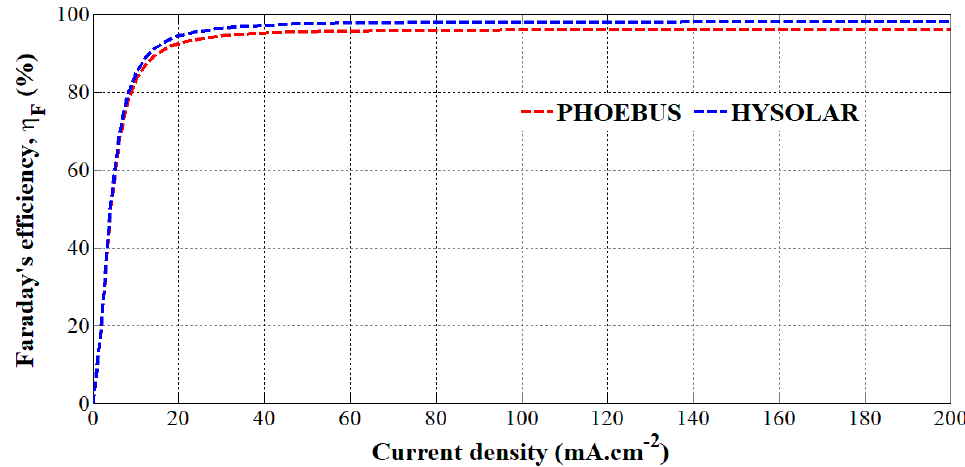
Figure 2. Faraday’s efficiency versus the current density for the PHOEBUS and HYSOLAR alkaline electrolyzers.